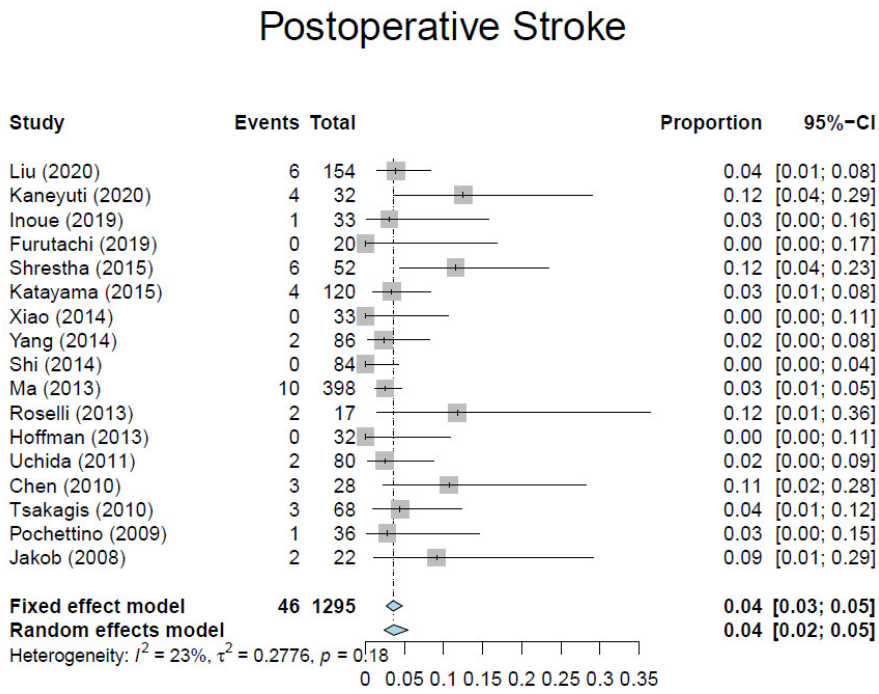
Figure 4. Forest plot depicting pooled estimates of stroke.